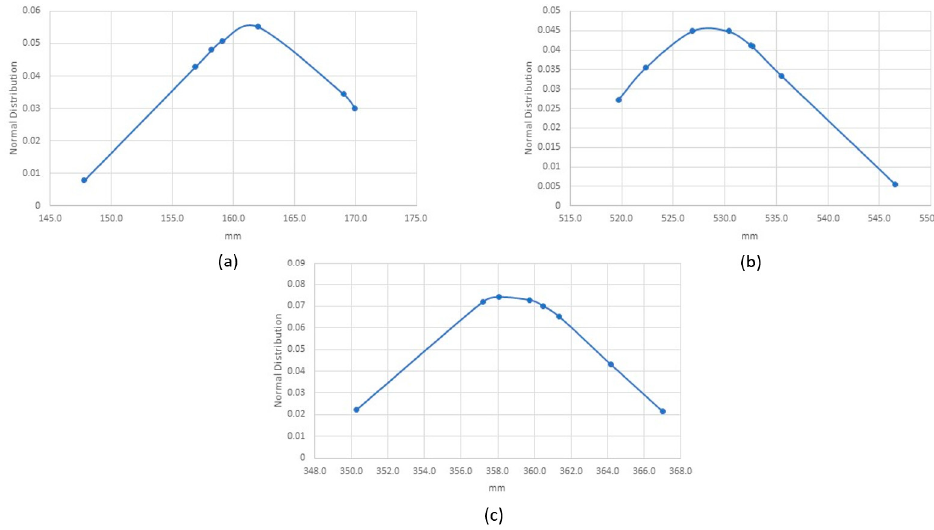
Figure 8. Trajectories of shoulder flexion–extension—load 2.2 kg.